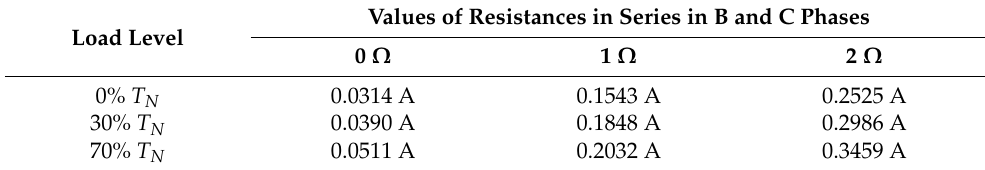
Table 6. Experimental data of motor negative sequence current.